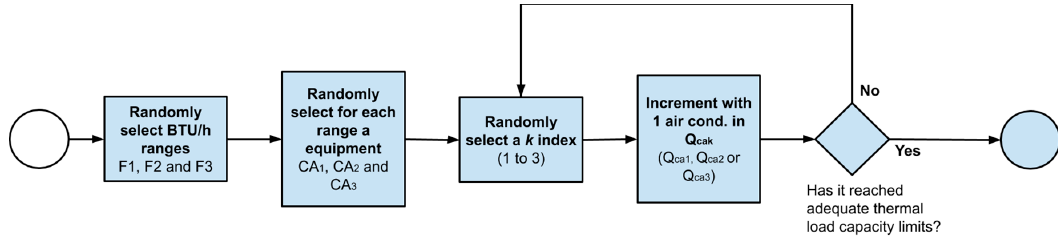
Figure 4. Chromosome formation process of the proposed methodology